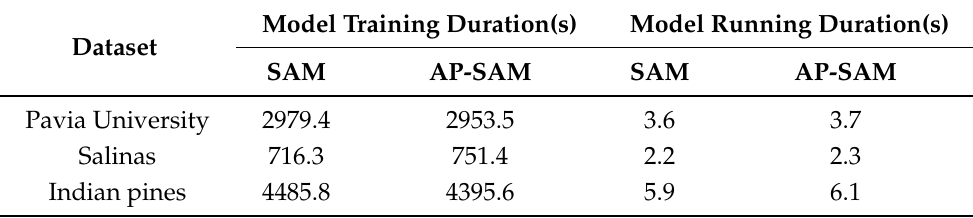
Table 5. Running Efficiency of AP-SAE Model on Different